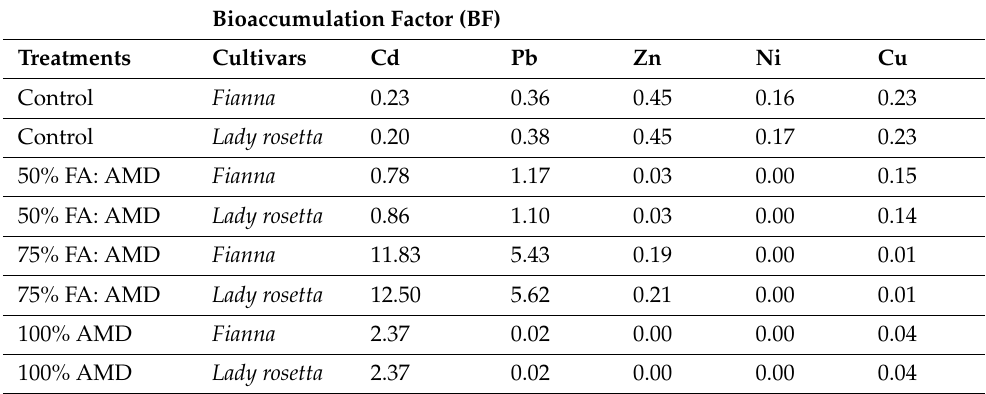
Table 2. Effect of AMD treatments on the bioaccumulation factor (BF) of two potato varieties ( Fianna and Lady rosetta ).